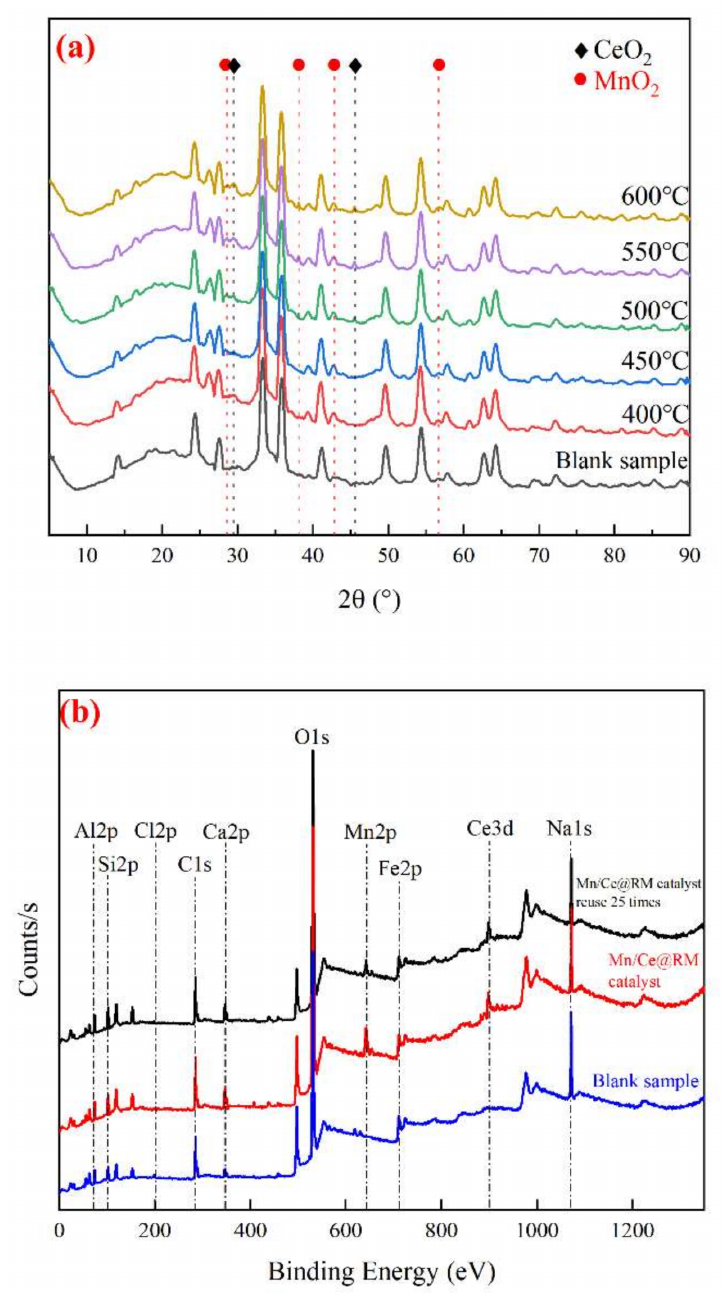
Figure 4. ( a ) XRD characterization results; ( b ) XPS characterization results: XPS full